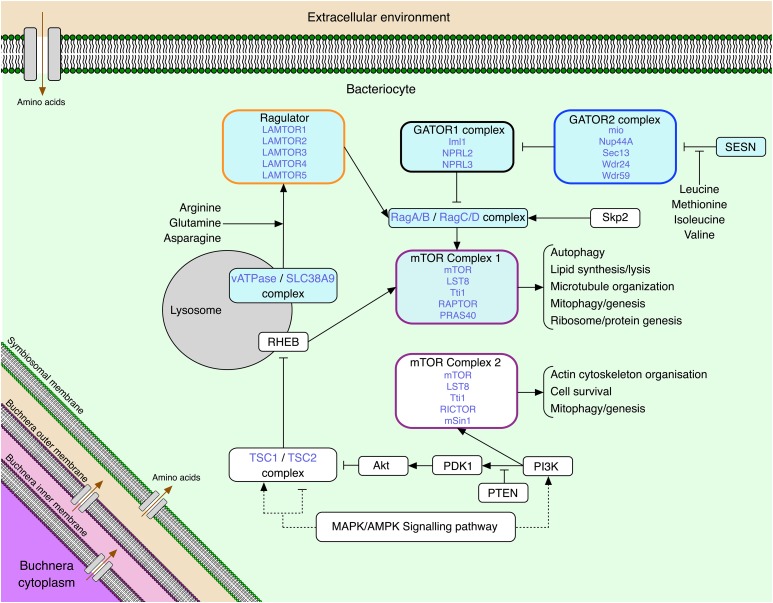
The mTOR pathway within an aphid bacteriocyte. The names of complexes are written in black at the top of their box, with their constituent genes in blue. Orthologs to known amino acid sensing genes and complexes are shaded blue. (Amino acid inputs: Rebsamen et al. 2015; Wolfson et al., 2016)